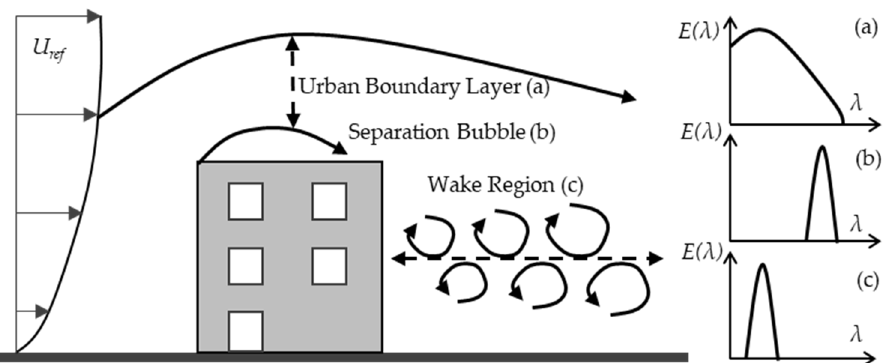
Figure 1. ( left ) Turbulent structures around a building and ( right ) associated energy wavelength.